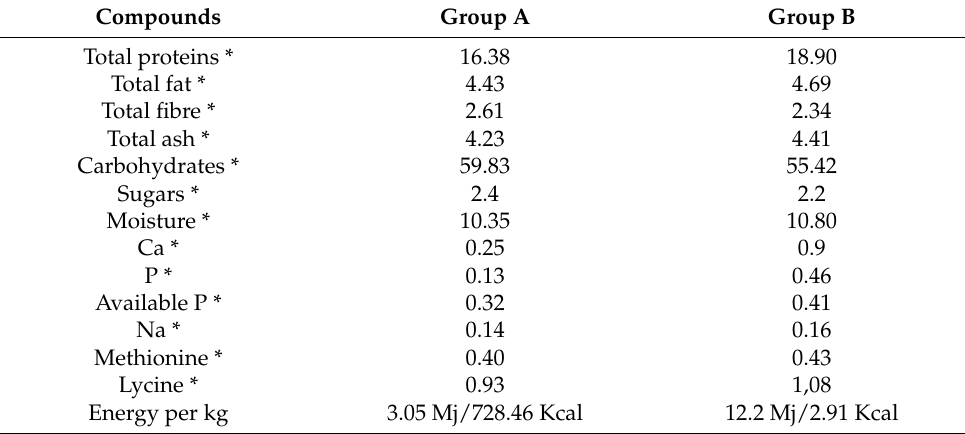
Table 4. Ingredients and nutrient composition of basal feed (Group B) and on corn silage supple- mented with pomegranate and avocado pulp and seed wastes (Group A). Compounds Group A Total proteins